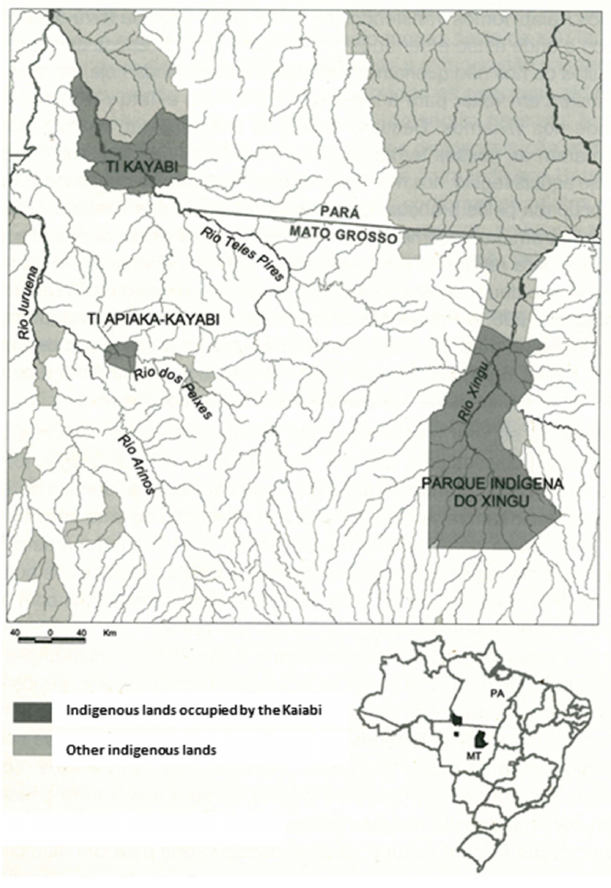
Fig. 1 . Map showing the location of the study area, including three Kawaiwete (Kaiabi) lands in the Amazon: Xingu Indigenous Park, TI Kayabi in the Teles Pires River, and TI Apiaká-Kaiabi in the Rio dos